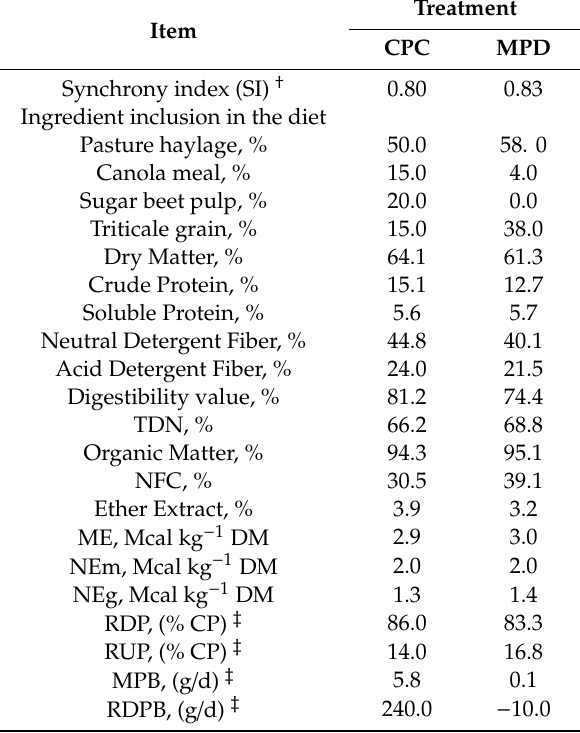
Table 2. Nutritional characteristics of the diets, ingredient inclusion, and synchronize